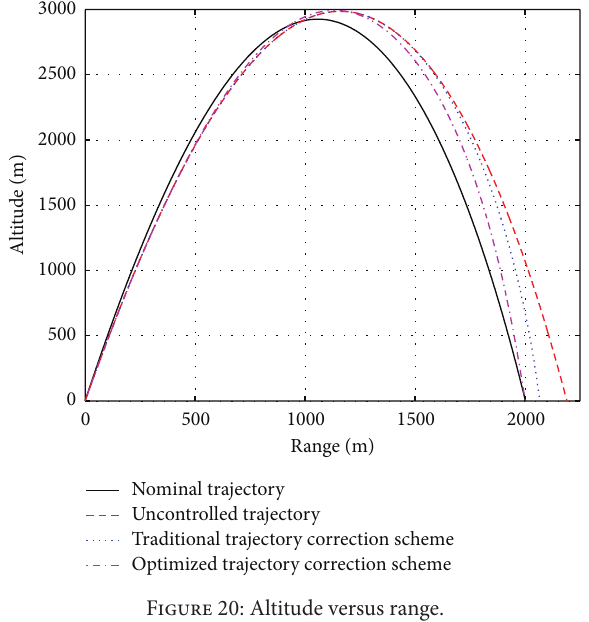
Figure 20: Altitude versus range.